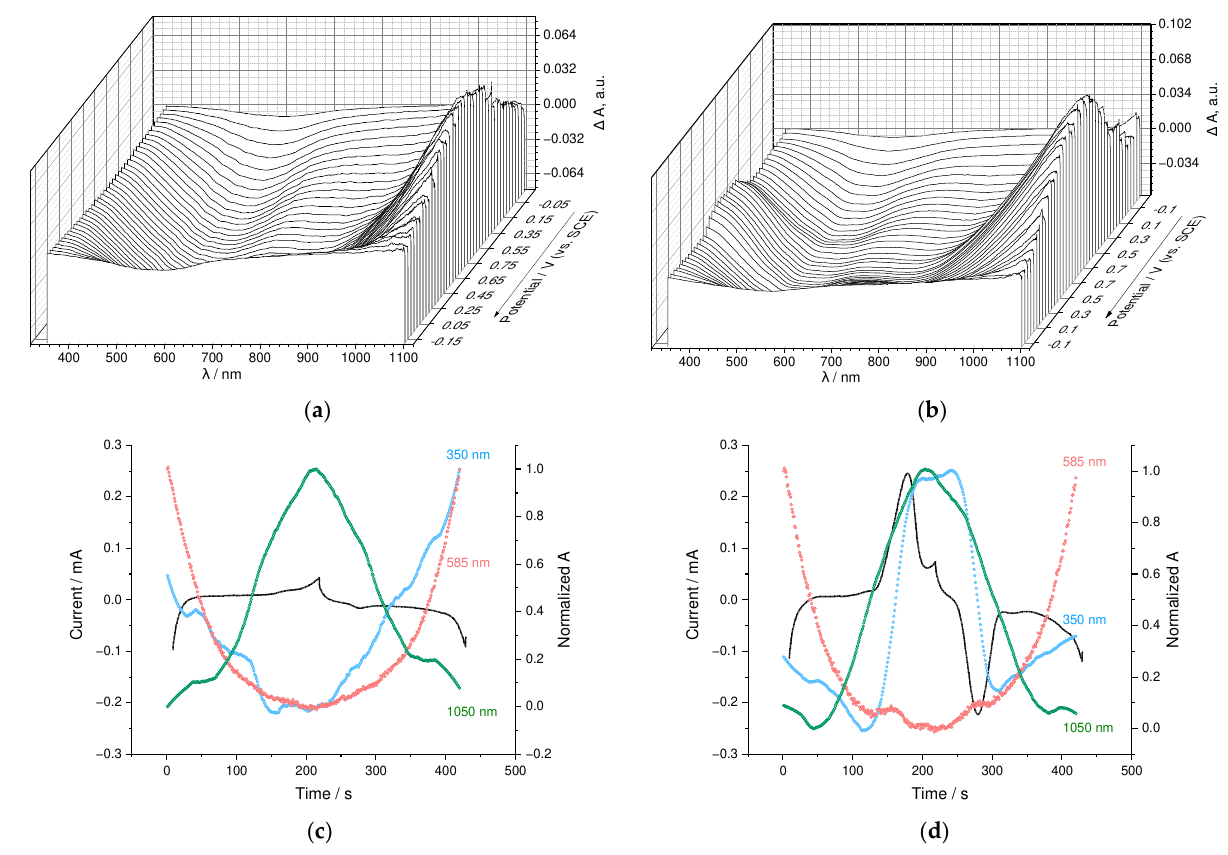
Figure 10. Three-dimensional spectroelectrochemical E-λ plots for ( a ) PEDOT:PSS and ( b ) PE- DOT:SPVC films; CV and potential-dependent absorbance variations at selected wavelengths for ( c ) PEDOT:PSS and ( d ) PEDOT:SPVC films plotted vs. time; 0.1 M HClO 4 , 5 mV·s −1 . The PEDOT spectroelectrochemical response appeared to be nearly the same for both materials, which indicates that the SPVC component does not influence the redox processes on a PEDOT chain. To examine the charge distribution between the PEDOT and SPVC in the material, we performed an open circuit potential (OCP) relaxation spectroelectrochemical experiment. PEDOT:PSS and PEDOT:SPVC films were potenti- ostatically charged at 0.8 V until the zero current and then left in the electrolyte in OCP mode. UV-Vis spectra were recorded during the relaxation of the film to monitor the changes in the oxidation states of individual components.